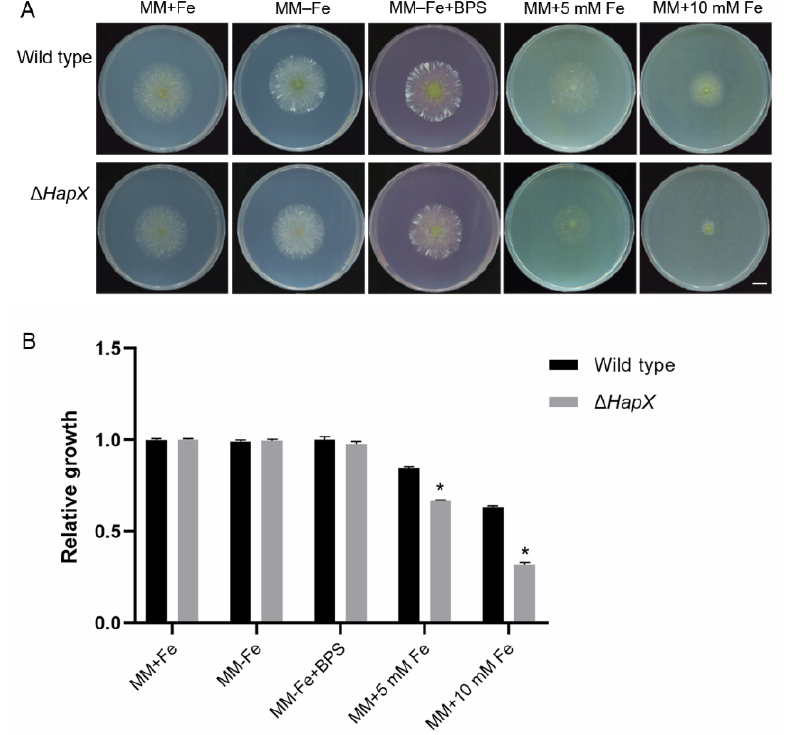
Figure 11. Deletion of HapX impairs fungal growth under conditions of high iron. ( A ) Colonies of the wild-type strain (NRRL 3357) and ∆ HapX strain grown on MM+Fe (0.03 mM FeSO 4 ), MM–Fe (no Fe), MM–Fe+BPS (0.2 mM BPS, but no Fe) plates, MM+5 mM Fe, and MM+10 mM Fe plates, respectively. The strains were cultured at 30 °C for 3 days. Bar = 1 cm. ( B ) Relative mycelial growth of the strains was obtained by measuring the diameter of fungal colonies and normalizing the data to the growth of wild-type and ∆ HapX on MM+Fe, respectively. Error bars represent the SD. * p < 0.05, significant difference from the wild-type group estimated by a Dunnett test. BPS, bathophenanthroline disulfonate. MM, minimal media; SD, standard deviation.